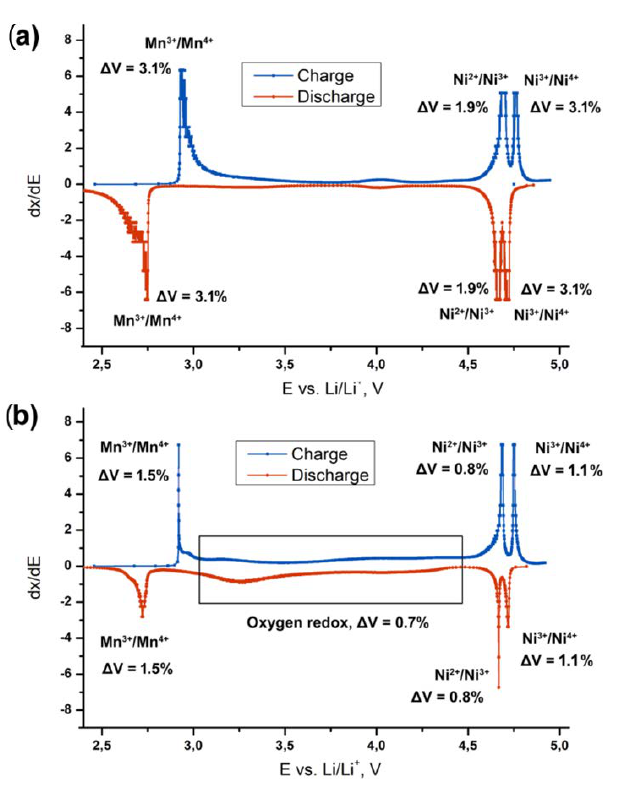
Figure 7. Differential capacity curves for the ( a ) LiNi 0.5 Mn 1.5 O 4 and ( b ) Li 2 Ni 0.5 Mn 1.5 O 4 electrodes, the corresponding redox transitions [23–26] and volume